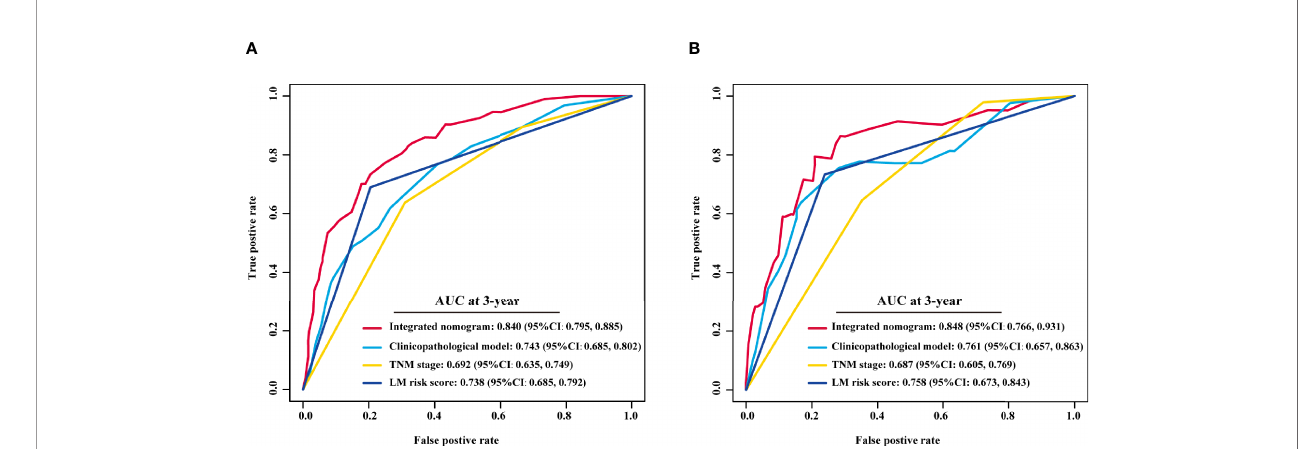
FIGURE 8 | Comparison of the integrated nomogram and other models in the training and validation cohorts. The 3-year time-dependent ROC curves of the integrated nomogram, clinicopathological model, TNM stage and LM risk score alone in the training (A) and validation cohorts (B) . TNM, tumor-node-metastasis; AUC, area under the ROC curve; ROC, receiver operating characteristic; LM, liver metastasis; CI, con fi dence interval.